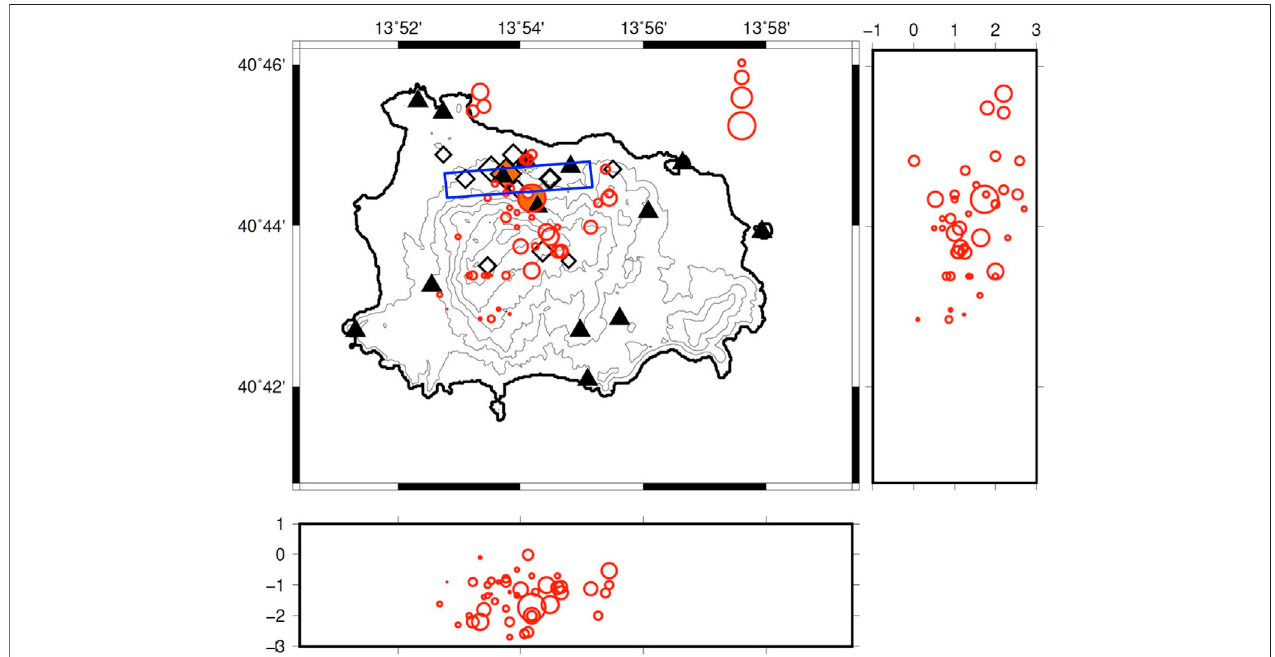
FIGURE 11 | Map of Ischia island with the seismic stations (black triangles), the locations of earthquakes (red circles) recorded by the seismic network and the locations of historical earthquakes (black diamonds). Instrumental and hystorical catalogs are from Selva et al. (2021) and integrated with the earthquakes occurred in 2020.Diamondandcircle fi lledinwithorangeindicatetheJuly28,1883andtheAugust21,2017earthquakes,respectively.Forinstrumentalearthquakes,thesizeofthe circleindicatesthemagnitudeaccordingtothescaleshownatthetoprightofthe fi gure.East-WestandNorth-Southsectionsareshown.Thebluerectangleshows thefaulttraceoftheAugust21,2017earthquakeretrievedinDeNovelliset al.(2018).Inthelowerand lateralpanels,thedepthsofthehypocentersareexpressedinkm.